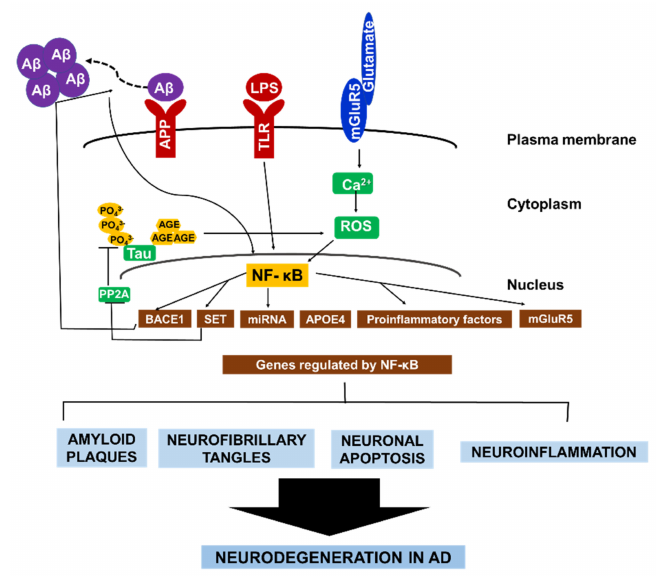
Figure 2. The central role of NF- κ B in AD pathology. NF- κ B facilitates the autocrine production of several factors that constitute AD pathology. NF- κ B activates BACE1, which promotes A β fibril formation. Consequently, A β fibrils directly activate NF- κ B, leading to the expression of APOE4,